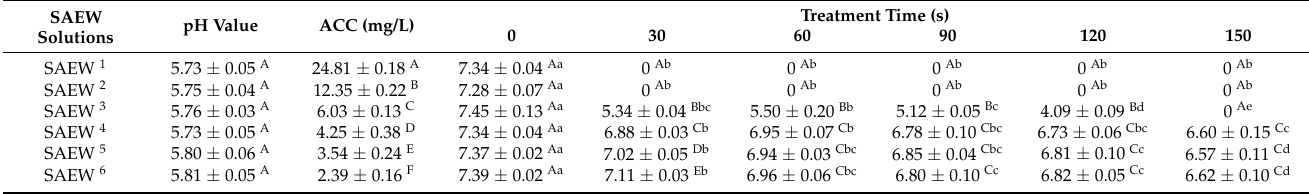
Figure 1. Preparation of slightly acidic electrolyzed water (SAEW) by self-made generator. SAEW was generated by passing sodium chloride and hydrochloric acid solutions through the electrolytic chamber of non-membrane. Table 1. The survival populations of L. monocytogenes (log 10 CFU/mL) treated by different SAEWs for different